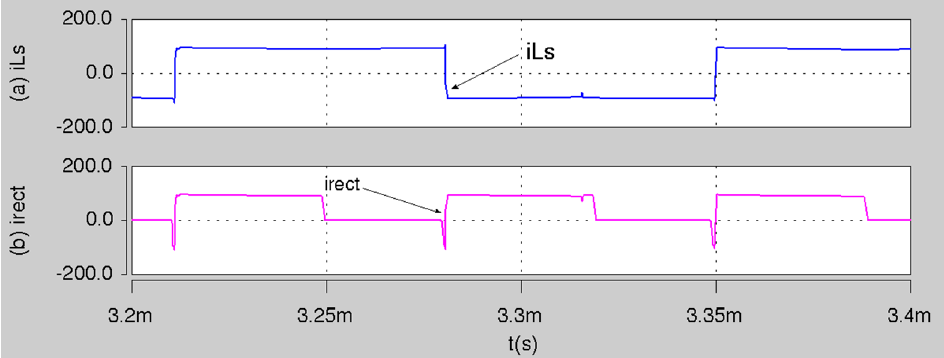
Figure 22. Simulations results for ( a ) i Ls ; ( b ) i rect . Supply: 127 V, 60 Hz, Output: 100 V, 5 kW